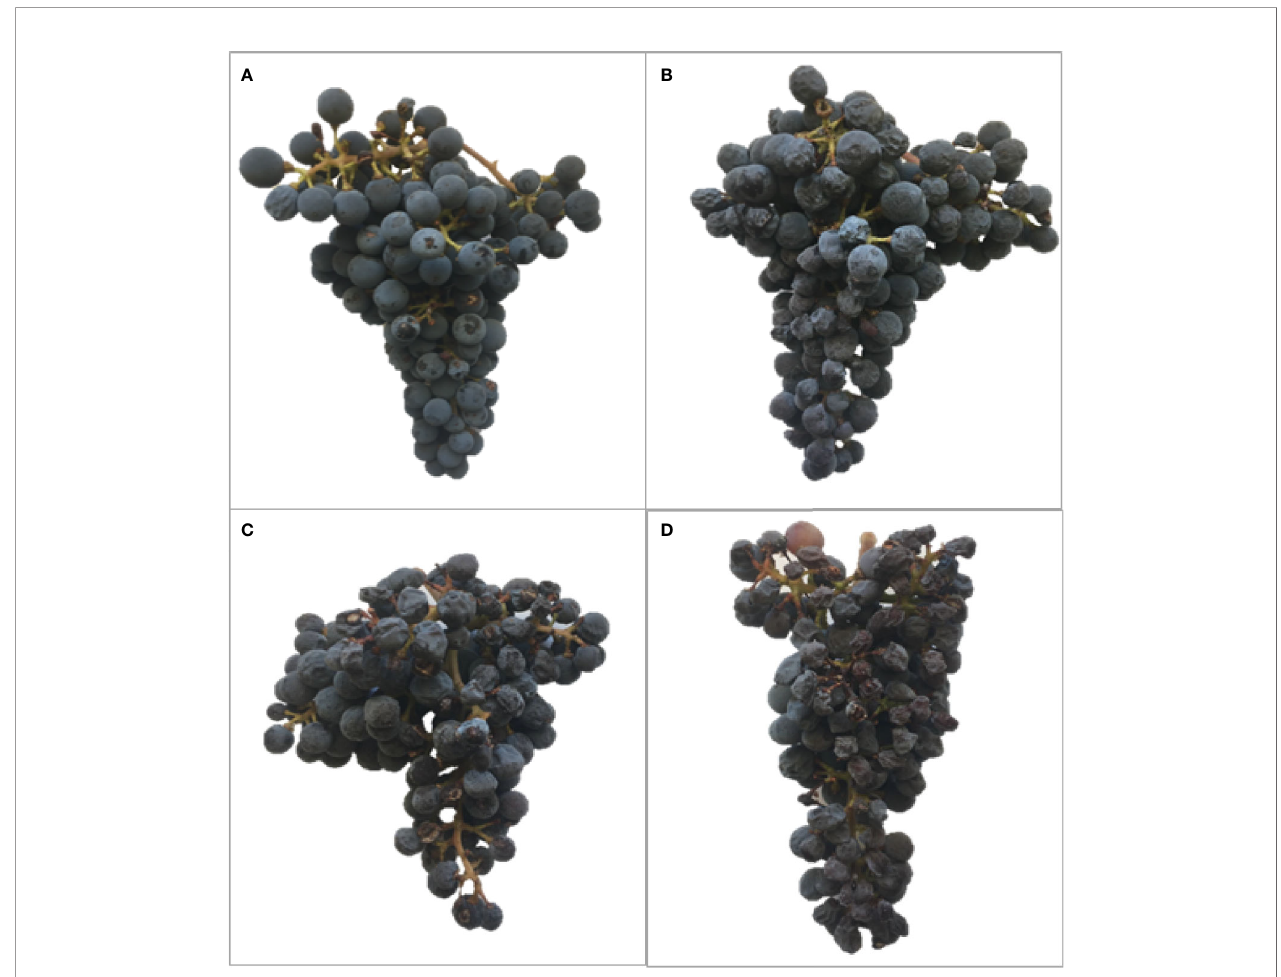
FIGURE 1 | Examples of harvested clusters from Cabernet Sauvignon with different degree of exposure: (A) Exp − (Non exposed berries collected from clusters in canopy interior), (B) Exp+ Deg − (exposed but not degraded, collected from Northeast exposed clusters), (C) Exp+ Deg+ (exposed and degraded, collected from Southwest exposed clusters) and (D) Exp+ Deg++ (exposed and very degraded grapes with signs of damage collected from Southwest exposed clusters), collected in Oakville, CA in